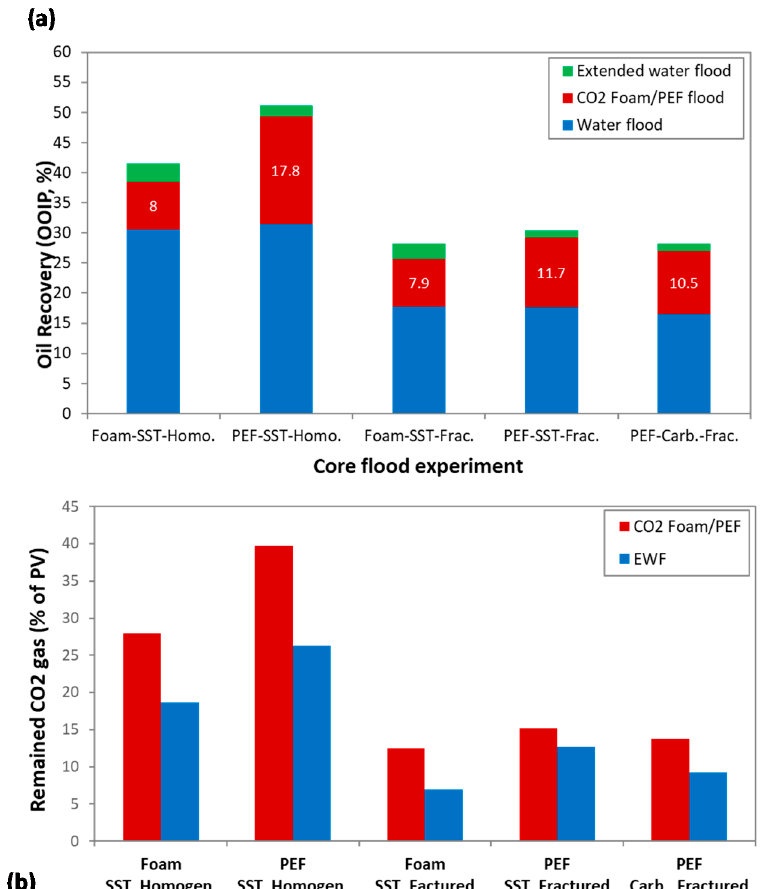
Figure 11. CO 2 PEF resulted in more oil recovery and more CO 2 storage than that of CO 2 foam ( a ). Ultimate oil recovery values for all experiments after waterflooding, foam/PEF injection, and extended water flood (EWF), and ( b ) amount of CO 2 gas (% of PV) remaining inside the porous media at the end of CO 2 foam/PEF injection and extended waterflood process. Some experiments were repeated, and the data agreed with 5% error. SST: sandstone, Carb.: carbonate.